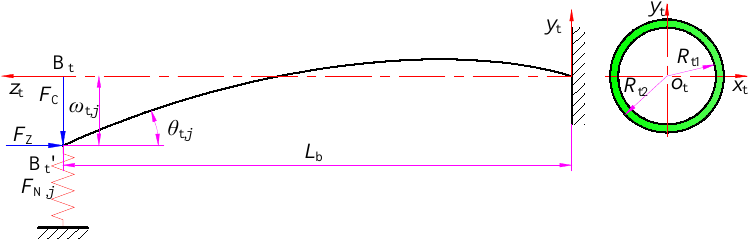
Figure 6. Bending deformation of the drilling tube in BTA deep hole drilling.